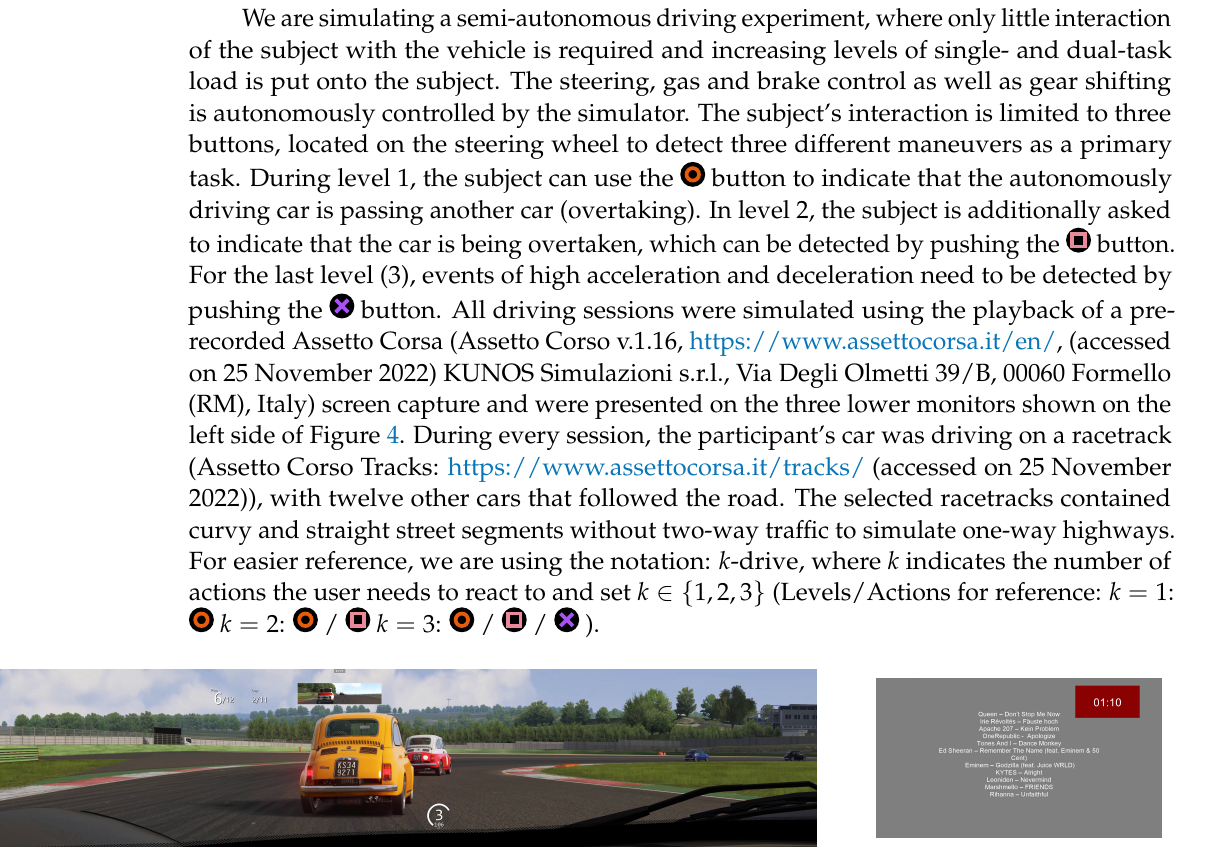
Figure 4. Screenshot of experimentation setup during driving. The left image shows the split-screen visualized on the three monitors with driving instruments, such as position, back mirror, current gear and velocity. The right image shows the remaining time during the experiment, as well as a list of songs the subject is instructed to add to the playlist on the virtual tablet